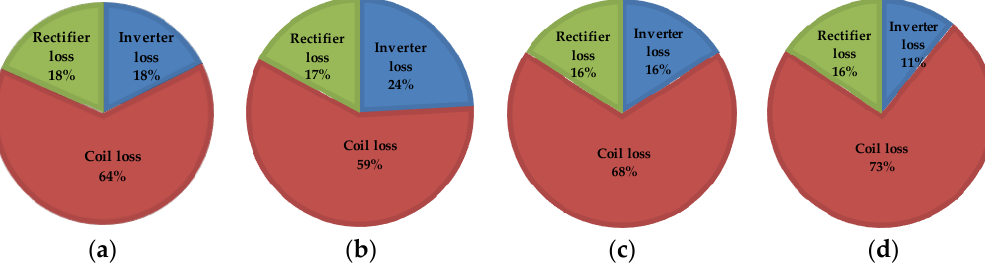
( d ) Figure 9. Experimental waveforms of the 85 kHz WPT system: ( a ) 85 kHz@85 kHz; ( b ) 95 kHz@85 kHz; ( c ) 80 kHz@85 kHz; ( d ) 85 kHz@95 kHz.